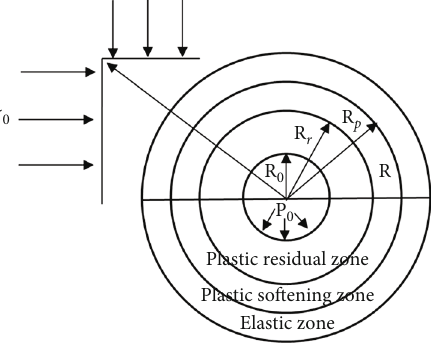
Figure 3: Mechanical model of tunnel surrounding